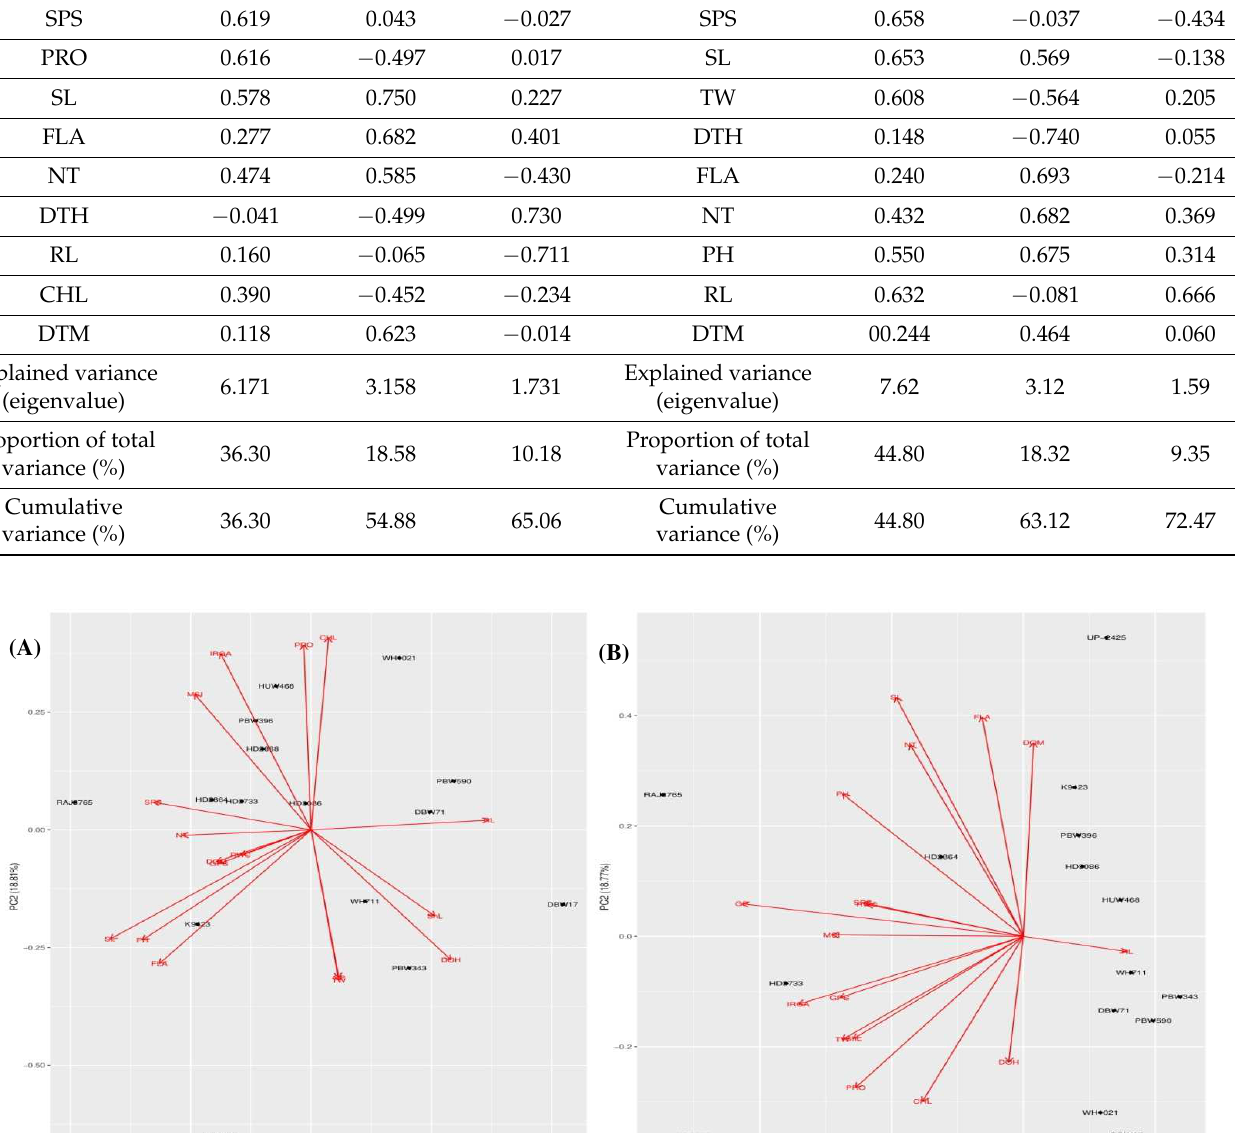
Figure 3. ( A ) Principal component biplot showing genotypic grouping under control conditions. ( B ). Principal component biplot showing genotypic grouping under 5%PEG treatment condition. ( C ). Principal component biplot showing genotypic grouping under 10% PEG treatment condition. ( D ). Principal component biplot showing genotypic grouping under 15% PEG treatment condition. Where Germination count (GC), shoot length (ShL), root length (RL), number of tillers plant −1 (NT), days to heading (DOH), plant height (PH), flag leaf area (FLA), days to maturity (DOM), spike length (SL), spikelet number spike −1 (SPS), number of grain per spike (GPS), Thousand Grain Weight (TW), Photosynthesis rate (IRGA), chlorophyll (CHL), Membrane stability index (MSI) and Relative water content (RWC) and proline (PRO). 4. Discussion Drought stress is known to cause a reduction in values for morphological traits (shoot length, root length, no. of tillers, days to heading, spike length, plant height and thousand grain weights) and affect the biological yield [19]. The wheat genotypes that were signifi- cantly tolerant to drought stress had major changes in their root system, photosynthetic